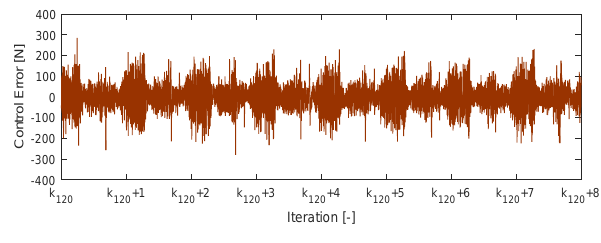
Figure 22: Control error two hours after convergence of the